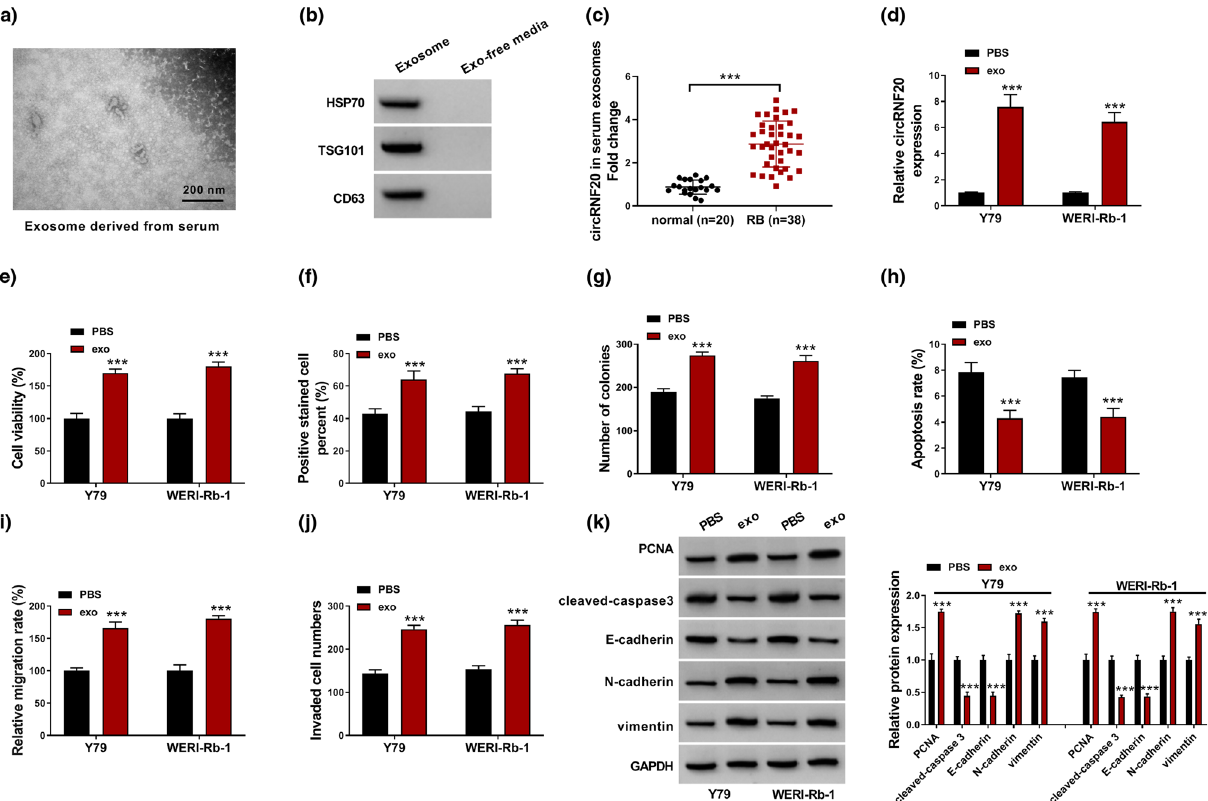
Figure 8: E ff ects of circRNF20 derived from RB patients ’ serums on RB cell growth, apoptosis and metastasis. ( a ) The morphology of exosomes was analyzed by TEM. ( b ) The protein levels of HSP70 and TSG101 were measured by western blot assay. ( c ) The level of circRNF20 in the exosomes derived from the serums of RB patients and normal controls was detected by qRT - PCR assay. ( d ) The expression of circRNF20 in Y79 and WERI - Rb - 1 cells incubated with RB patients serums ’ isolated exosomes was detected by qRT - PCR assay. ( e – j ) After Y79 and WERI - Rb - 1 cells were incubated with the exosomes derived from RB patient serums, cell viability, proliferation, apoptosis, migration and invasion were analyzed. ( k ) The protein levels of PCNA, cleaved - caspase 3, E - cadherin, N - cadherin and vimentin were measured through western blot assay. *** P <